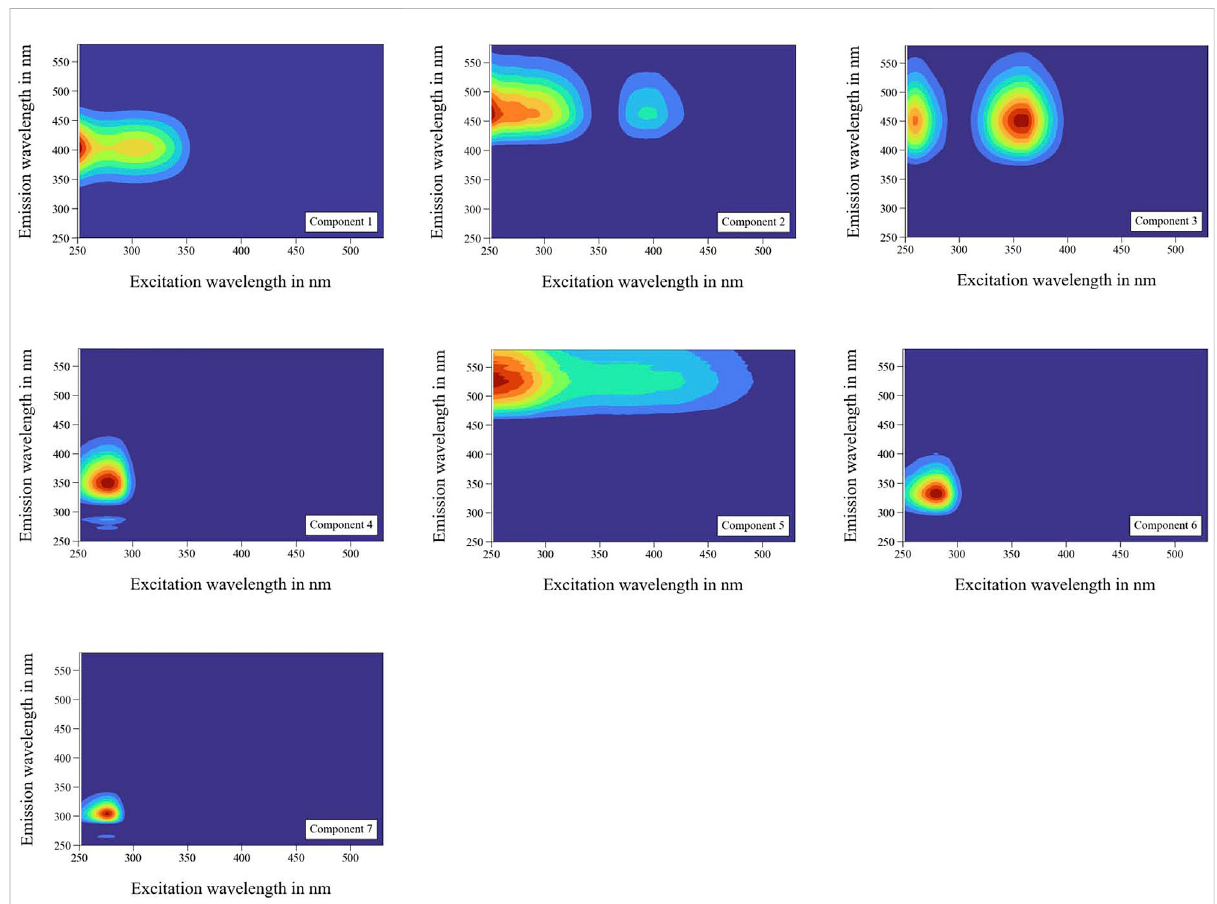
FIGURE 5 Fluorescent fi ngerprint of seven organic components in tap water with LB medium. Peak regions by pair of excitation ( λ Ex ) and emission ( λ Em ) wavelengths: Component 1 λ Ex = 252/303 nm, λ Em = 403 nm; Component 2 λ Ex = 252/393 nm, λ Em = 463 nm; Component 3 λ Ex = 261/357 nm, λ Em = 453 nm; Component 4 Component 7 λ Ex = 276 nm, λ Em = 302